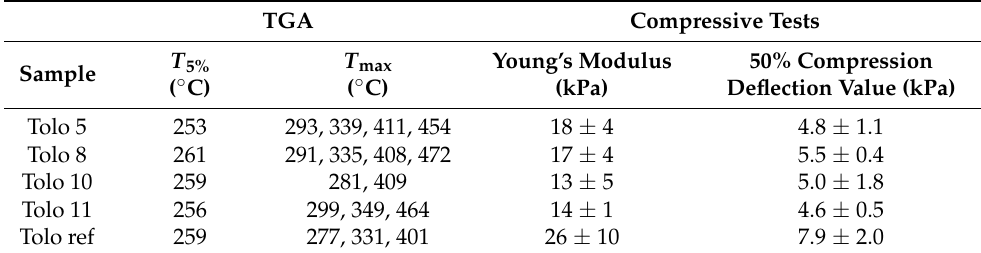
Table 5. Thermal and mechanical properties of PU foams.